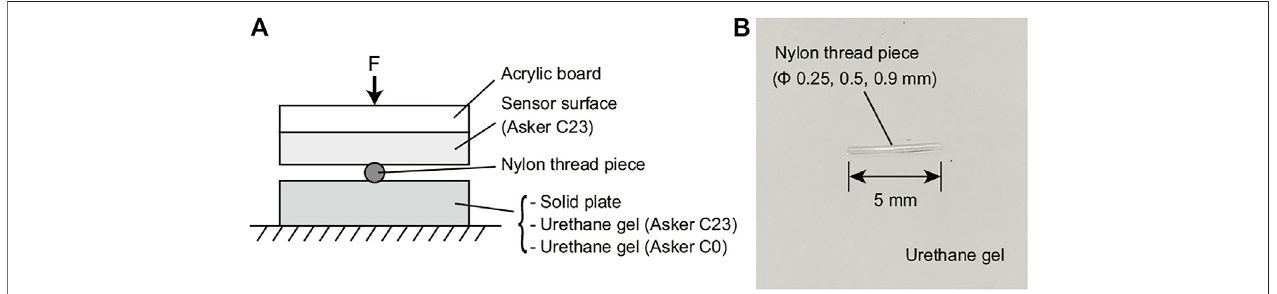
FIGURE 6 | Experimental setup for hard object piece detection experiment using arti fi cial objects. (A) arrangement of the materials. Three kinds of object ware used; Solid plate (metal tray), urethane gel with Asker C23 hardness (EXSEAL Gel tack series), and urethane gel with Asker C0 hardness (EXSEAL seitai gel series). On theseobject,thenylonthreadpiecewith5(mm)oflengthandwiththreedifferentdiameterwerearranged; ϕ 0.25(mm), ϕ 0.5(mm),and ϕ 0.9(mm). (B) pictureofthenylon thread piece located on the urethane gel sheet.